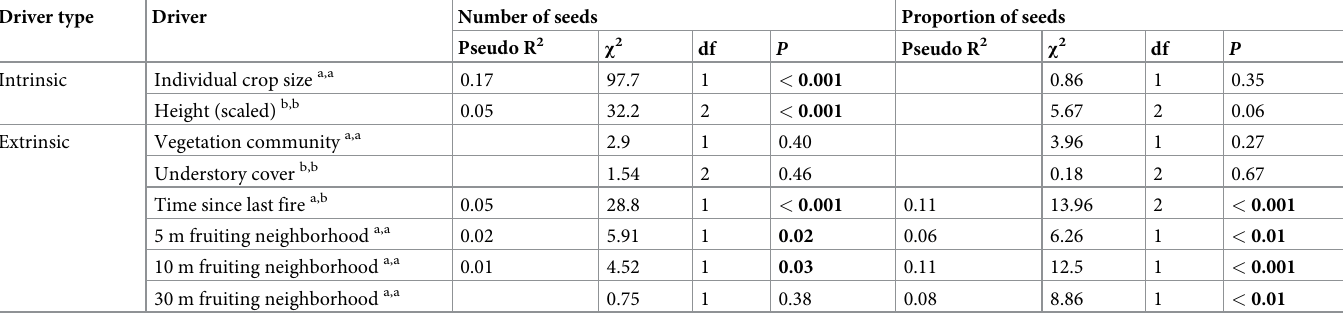
Table 3. Results testing for the significance of intrinsic and extrinsic drivers on the quantity component (number and proportion) of seed dispersal effectiveness. Model comparisons evaluated with type II likelihood ratio χ 2 tests are identified by letter codes after each driver for the number and proportion of seeds, respectively. P val- ues in bold indicate a significant effect ( α =